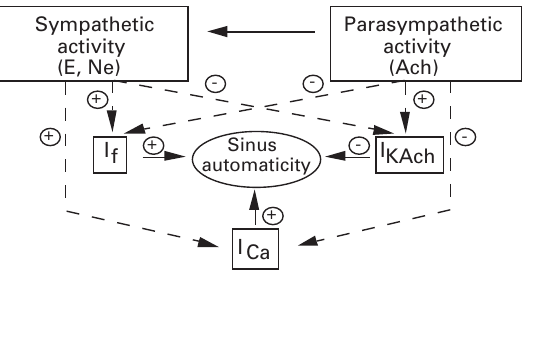
Figure 1 Effects of the auto- nomic nervous regu- lation on the ionic currents and the resulting changes of sinus automaticity. E = epinephrine; NE = norepinephrine; Ach = acetylcholine; Ica = calcium current; If = hyperpolarisa- tion-activated “pace- maker” current; IKAch = potassium current. (Adapted from reference